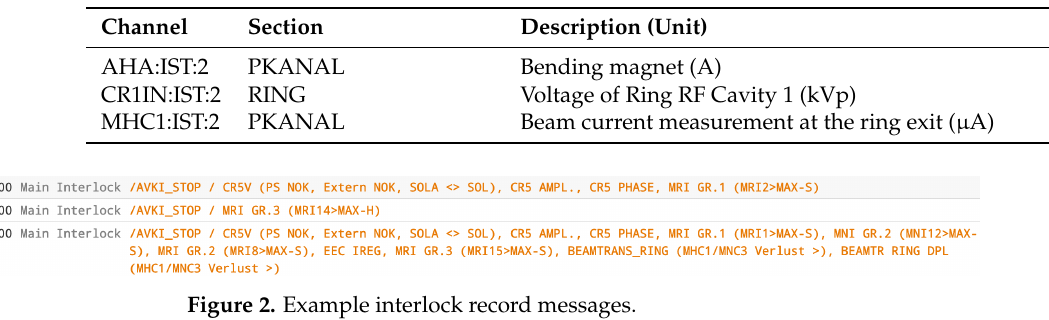
Figure 1. Different HIPA sections of the channels. Table 1. List of some example channels.